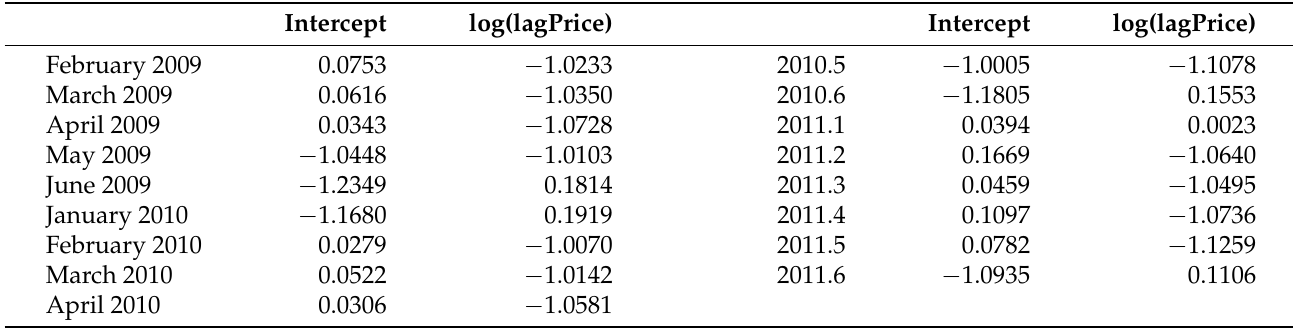
Table A4. Mixed model. Random effects